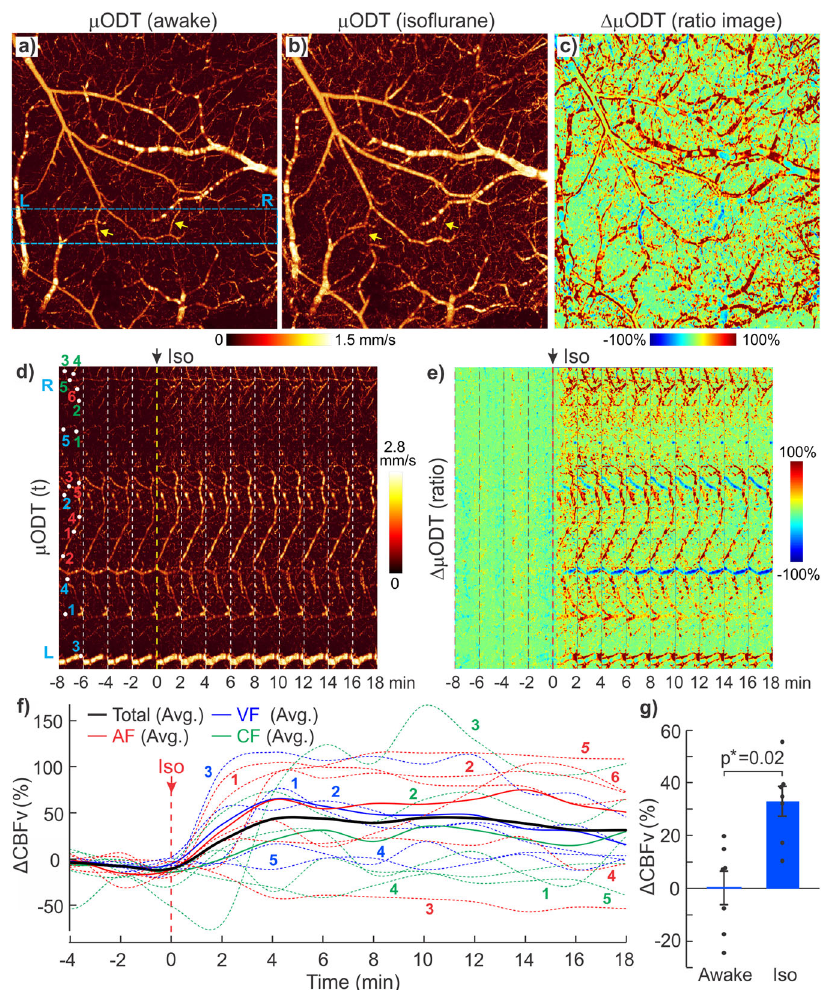
Fig. 4 3D μ ODT images of mouse sensorimotor cortex in awake vs Iso-anesthetized states. a , b Raw μ ODT images of awake vs Iso states and their ratio image. c Image size: 2.3 × 2.5 × 1.2 mm 3 ); d , e time-lapse images μ ODT(t) and ratio changes Δμ ODT from awake to Iso anesthesia (image size: 2.3 × 0.3 × 1.2 mm 3 ); f Iso-induced CBFv increases; g a comparison of mean Δ CBFv between awake state ( t : − 8 – 0 min) and Iso anesthesia ( t : 20 – 30 min) across animals ( p * = 0.02, m = 8 RoIs/animal, n = 7